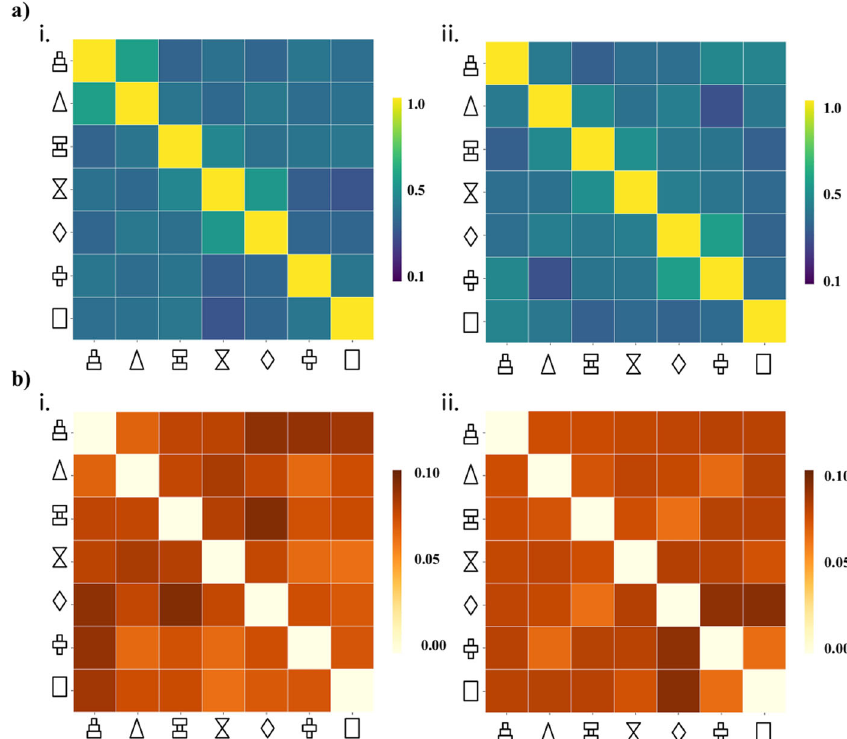
Fig. 5 Quanti fi cation of similarities and differences in BBP shapes. Shape-wise comparison of the ( a ) mean cosine similarity and ( b ) mean similarity standard deviation between the extracted feature vectors for each shape at (i) 300 K and (ii) 320 K. Legend for the similarity and standard deviation values is presented alongside each plot. Shape legend same as Fig.